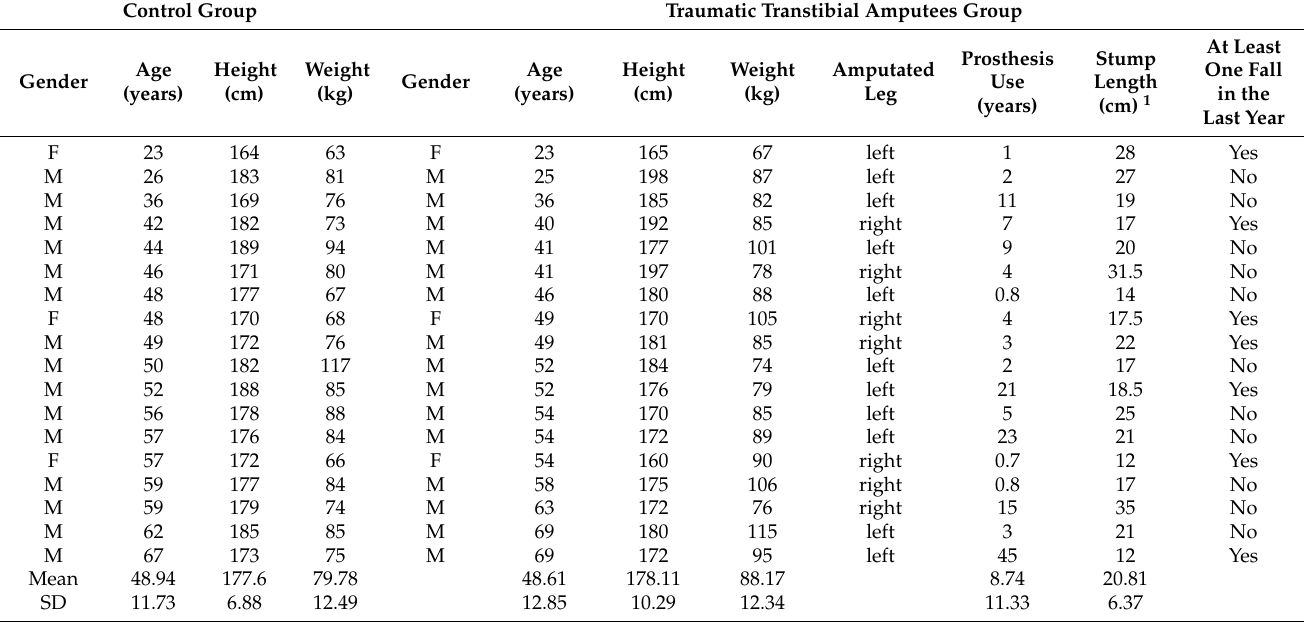
Table 1. Participant